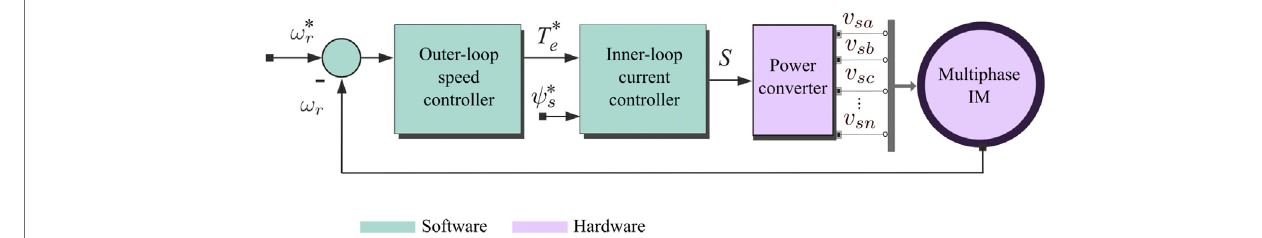
FIGURE 1 | Schematic diagram of the closed-loop FOC of a multiphase IM.